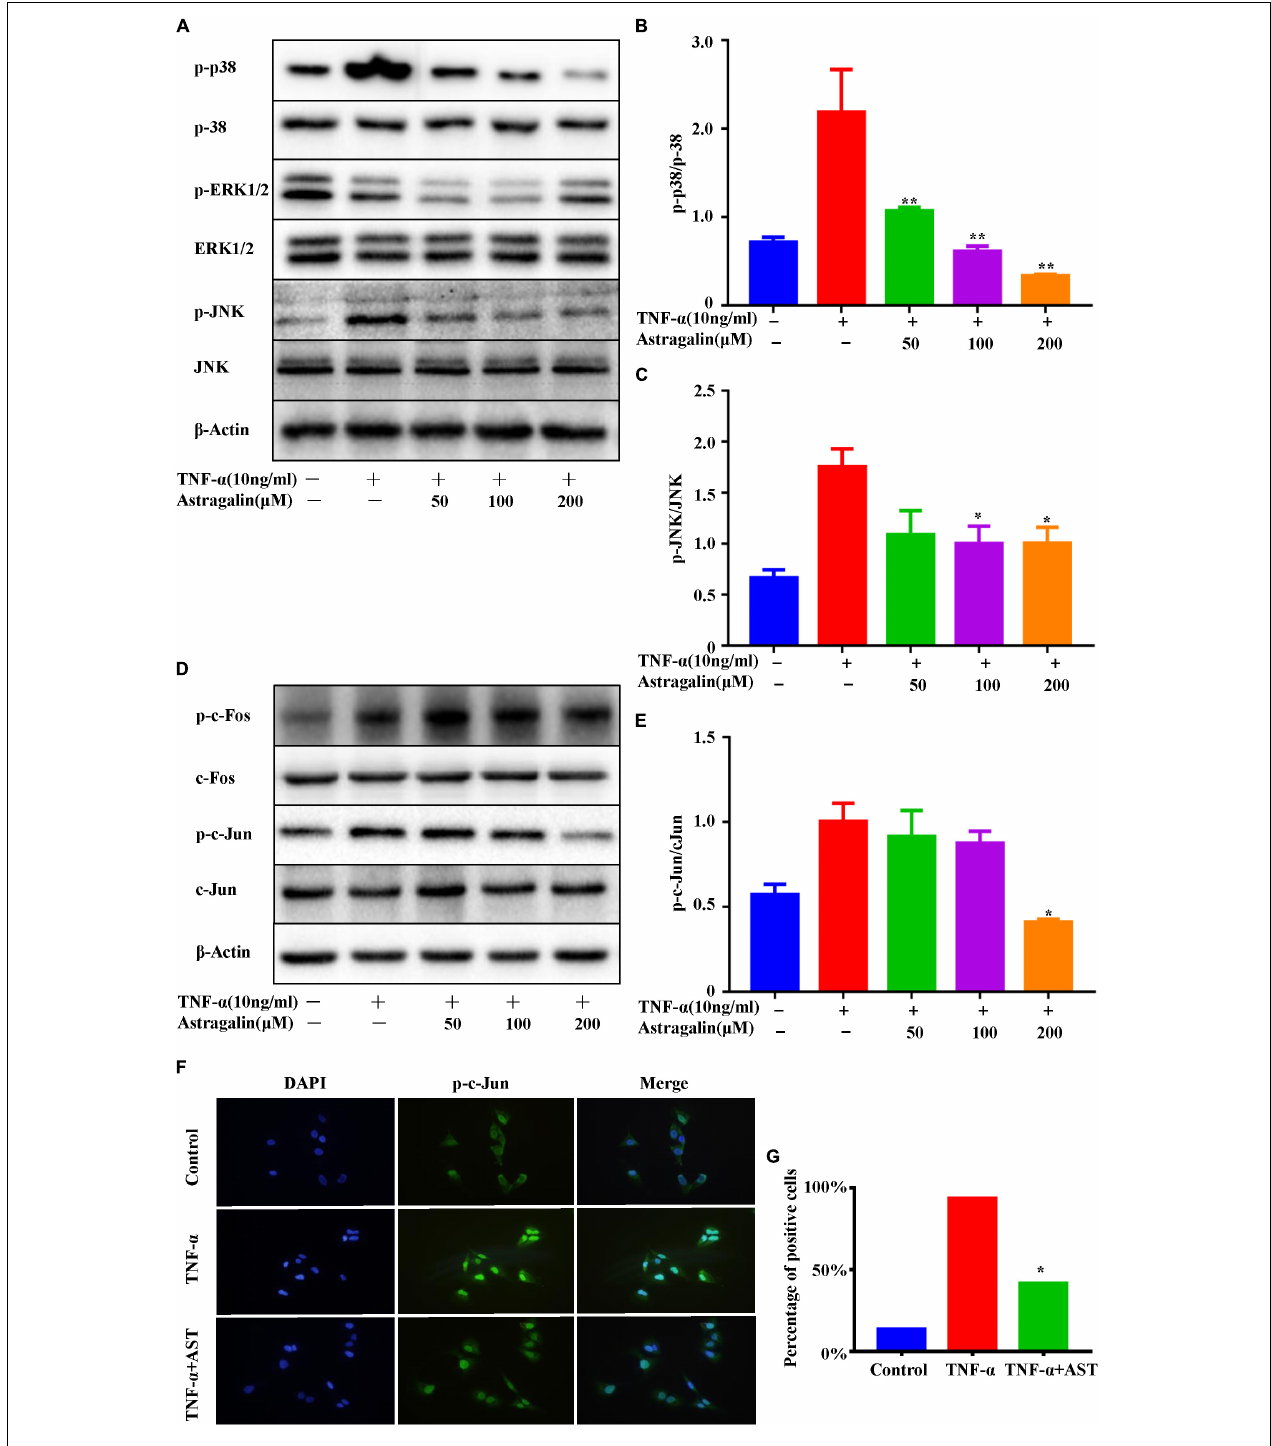
FIGURE 6 | Astragalin inhibited TNF α -induced activation of MAPK and AP-1 pathways. MH7A cells pretreated for 2 h with various concentrations of astragalin (0, 50, 100, 200 µ M), and then exposure to TNF- α (10 ng/ml) for 0.5 h, the total and phosphorylated levels of JNK, ERK1/2, and p38 were determined by Western blot analysis (A–C) . The total and phosphorylated levels of c-Jun, c-Fos were analyzed by Western blot analysis (D,E) . MH7A cells pretreated with astragalin (200 µ M) or not for 2 h, and then exposure to TNF- α (10 ng/ml) for 0.5 h. Immunofluorescence analysis was used to detect intracellular localization of p-c-Jun. Representative 400 × images (F) . More than 200 cells from each sample were measured (G) . Data are shown as mean ± SEM of three independent experiments. ∗ p < 0.05, ∗∗ p < 0.01 compared with TNF- α stimulation alone.